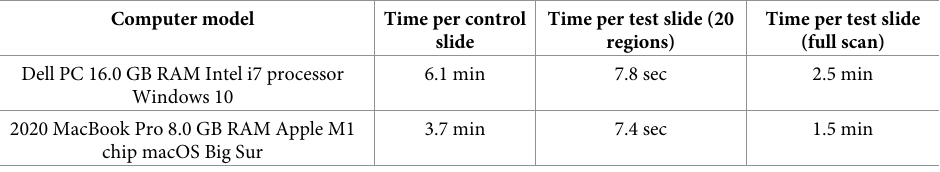
Table 1. Example run times on a PC versus a